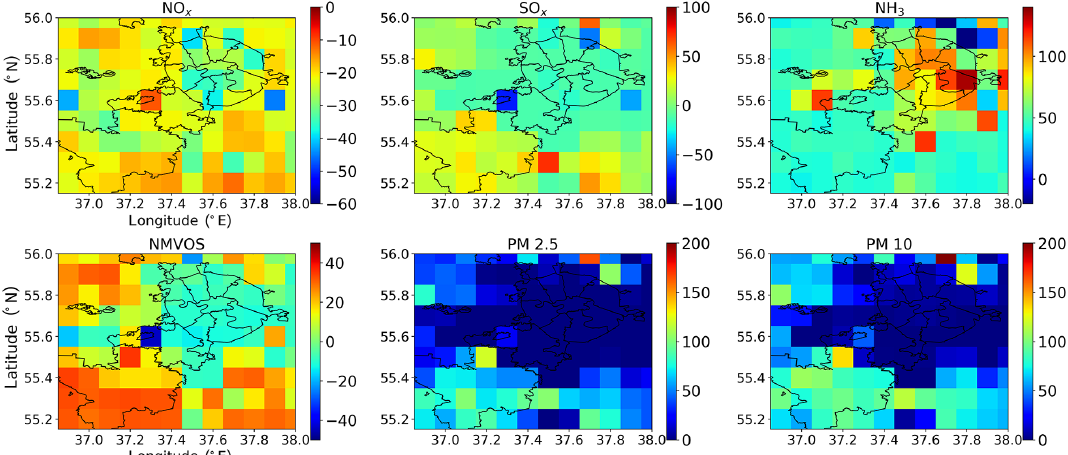
Figure 10. Ratio of emissions of gases and particle matter averaged over the 2011–2016 period to the emissions averaged over the 2003–2009 period, in percentages. EMEP dataset (http://www.ceip.at/new_emep-grid/01_grid_data, last access: 1 August 2019; EMEP/CEIP, 2019).